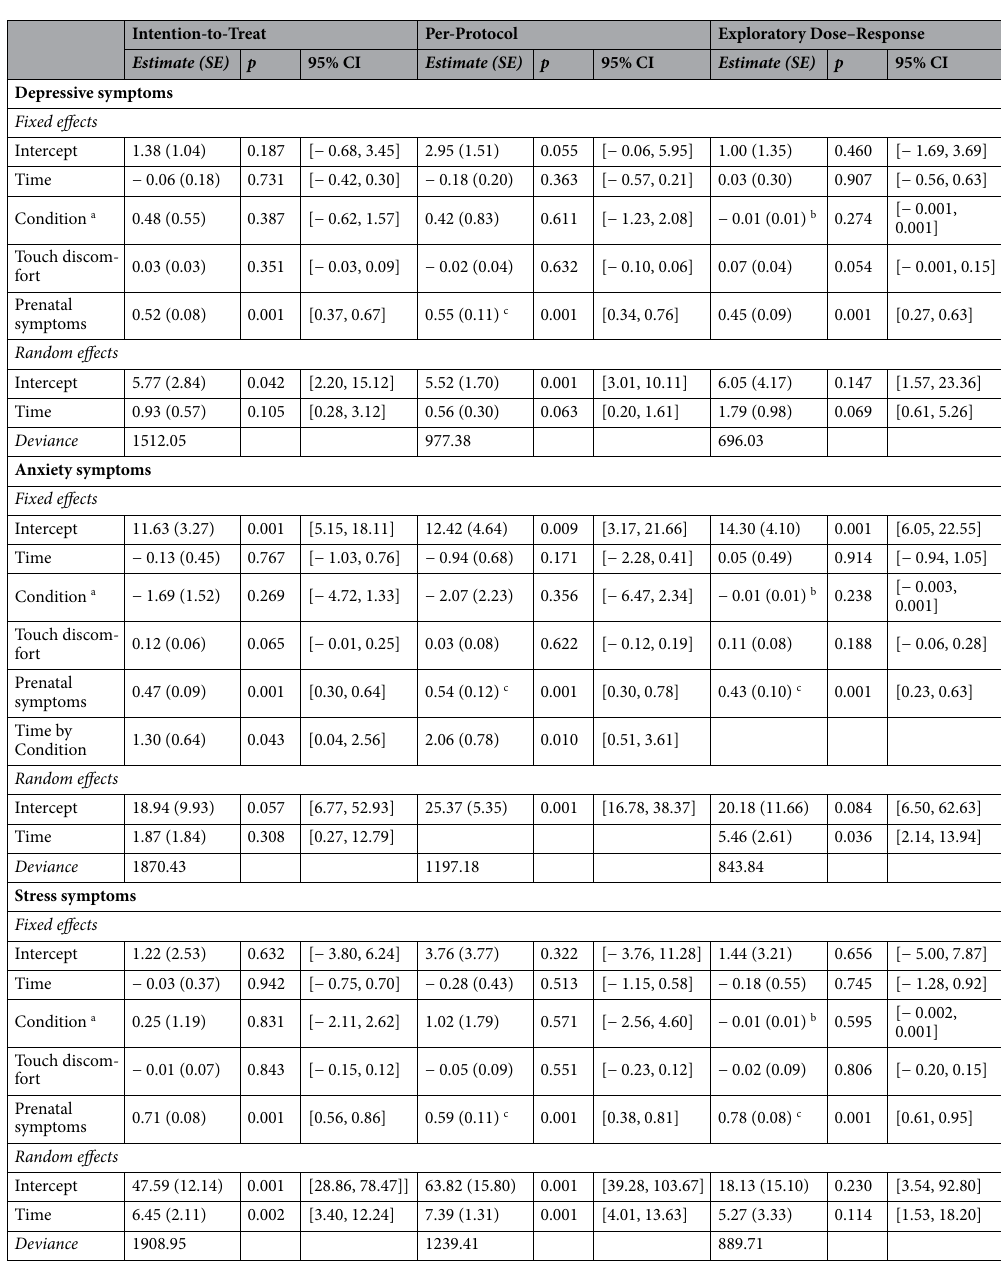
Table 3. Best fitting multilevel models predicting maternal depressive, anxiety, and stress symptoms from week 2 to week 12 postnatally. a Condition: 0 = CAU; 1 = SSC. b Values are for dose variable rather than condition variable. c For the best fitting final multilevel models, prenatal mental health symptoms were included before touch